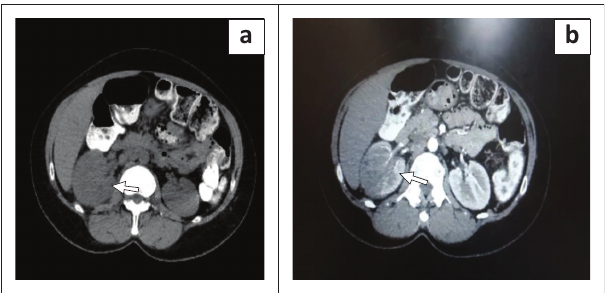
FIGURE 1: Radiological imaging: (a) Computed tomography scan show iso-dense heterogeneous renal mass (arrow); (b) Magnetic resonance imaging show iso-intense right renal mass with solid and cystic areas